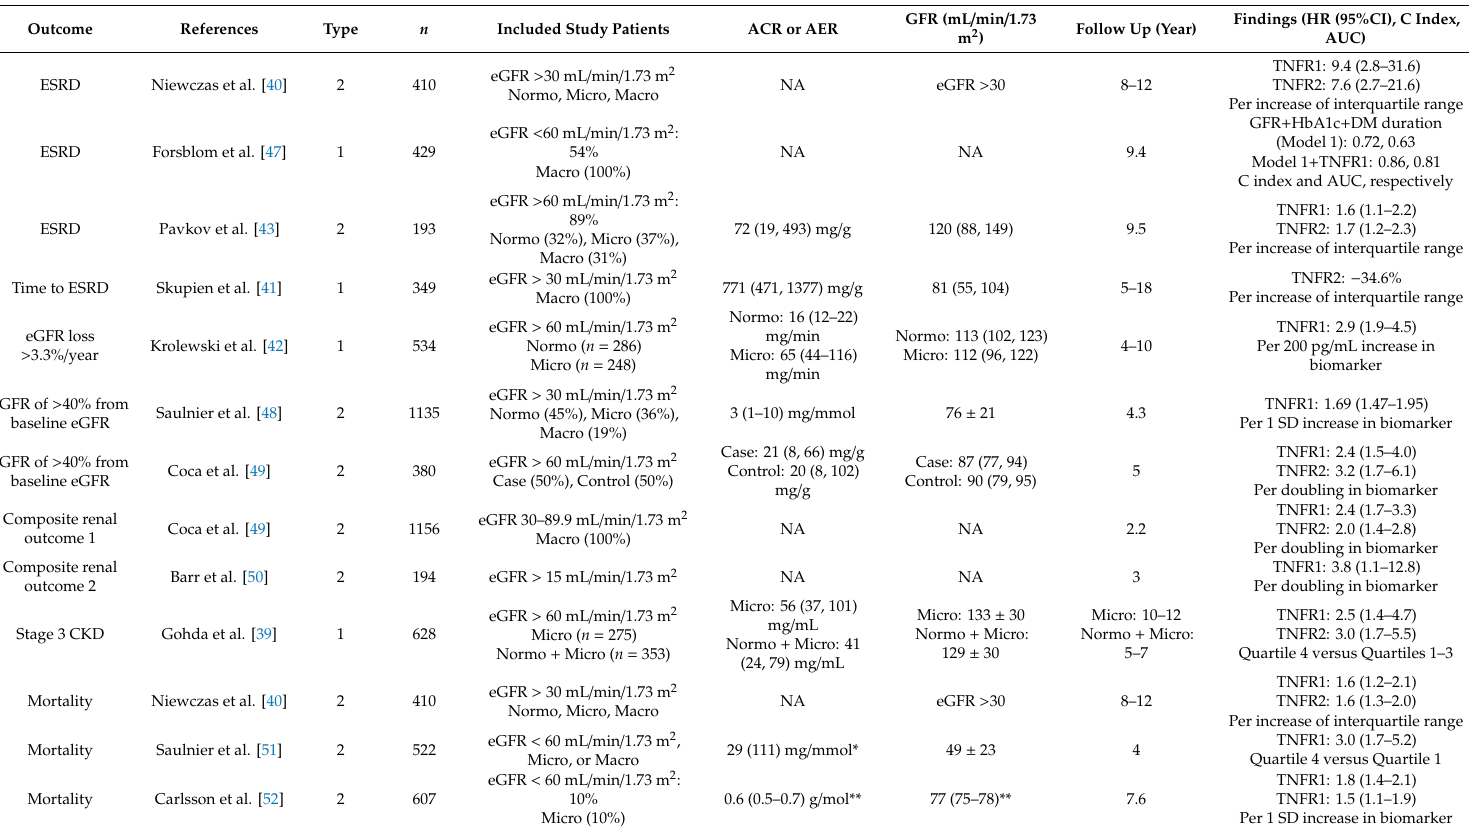
Table 1. Characteristics of clinical studies, diabetic kidney disease-related outcome, and circulating tumor necrosis factor receptor levels in patients with type 1 and type 2